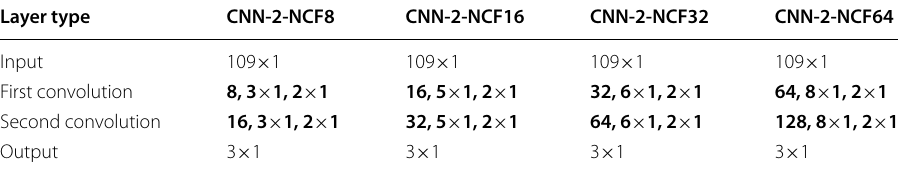
Table 4 Variation of CNN‑2 with the number of convolutional filters Layer